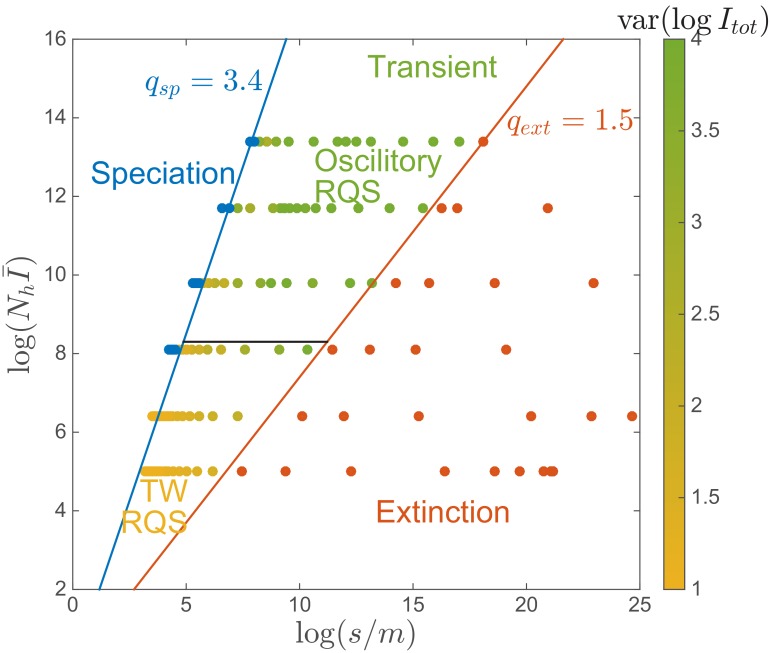
‘Phase diagram’ in the clone-based simulation.The data points are assigned to phases using the following criteria. The extinction phase (red): τext<10⁢τsw; The speciation phase (blue): τsp<10⁢τsw; The transient RQS regime (yellow and green): otherwise. Red and blue lines correspond to the extinction boundary qe⁢x⁢t and speciation boundary qs⁢p respectively, defined for τ=10⁢τsw. The black solid line corresponds to the onset of spontaneous oscillation log⁡(Nh⁢I¯)=8.3. Color in the transient phase labels the amplitude of prevalence var⁢(log⁡It⁢o⁢t), increasing from yellow to green. Simulation set d=50.